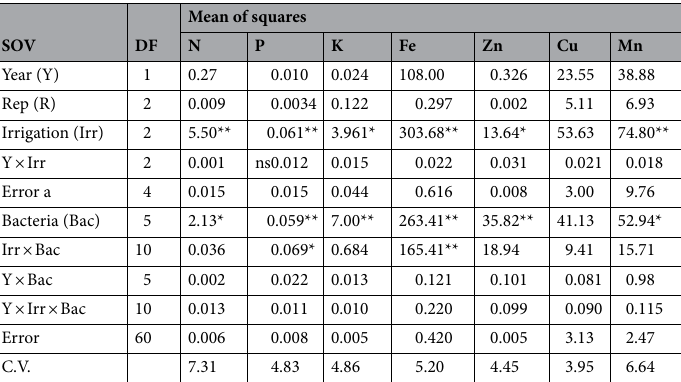
Figure 2. The effect of inoculation with different strains of Pseudomonas fluorescens (P 1 , P 3 , P 8 , P 14 and 4 strains: combination of four strains) under three irrigation levels on P and Fe content of sweet corn leaf. Different letters mean ± standard error bars showed significant difference (LSD at p ≤ 0.05).